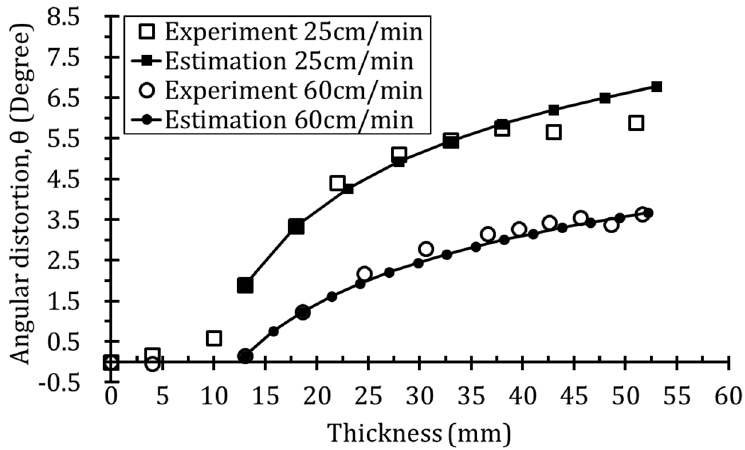
Figure 12. Comparison of experimental and predicted values of V butt welding experiment with 50 mm thickness for welding conditions of 280 A, 30 V, and varying travel speed.